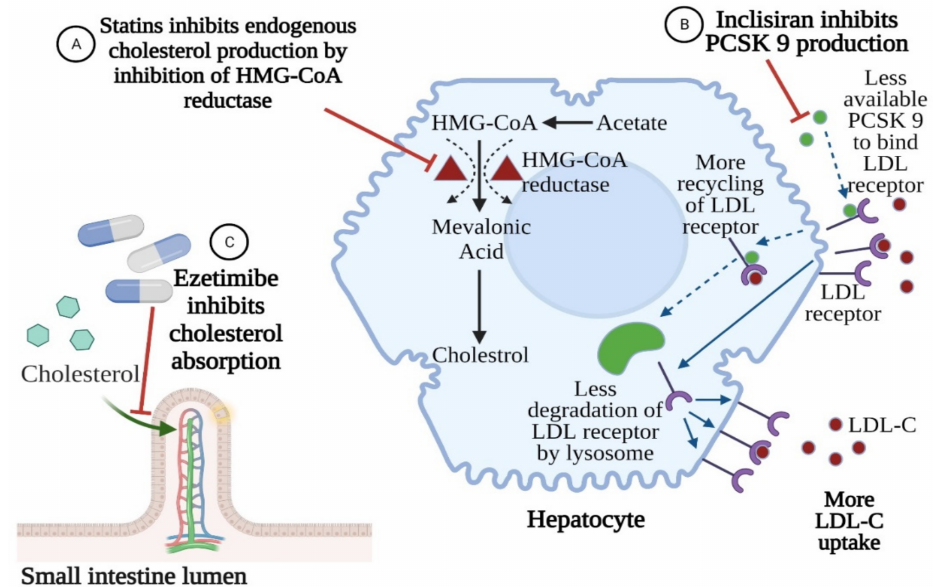
Figure 4. Compatible mechanisms of action of statins, ezetimibe, and inclisiran. Inclisiran inhibits PCSK9—proprotein convertase subtilisin-kexine type 9. LDL-C, low density lipoprotein cholesterol. Created with BioRender.com (accessed on 12 May